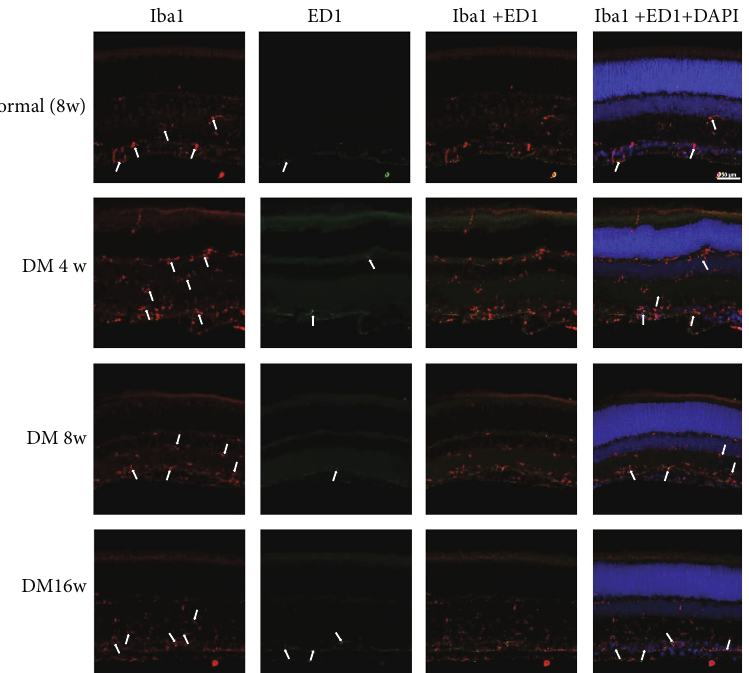
Figure 4: Changes in microglia in normal control and experimental diabetic rat retinas. The retinas were immunostained with Iba-1 antibody (red) and ED1 (green). The nuclei were counterstained with DAPI